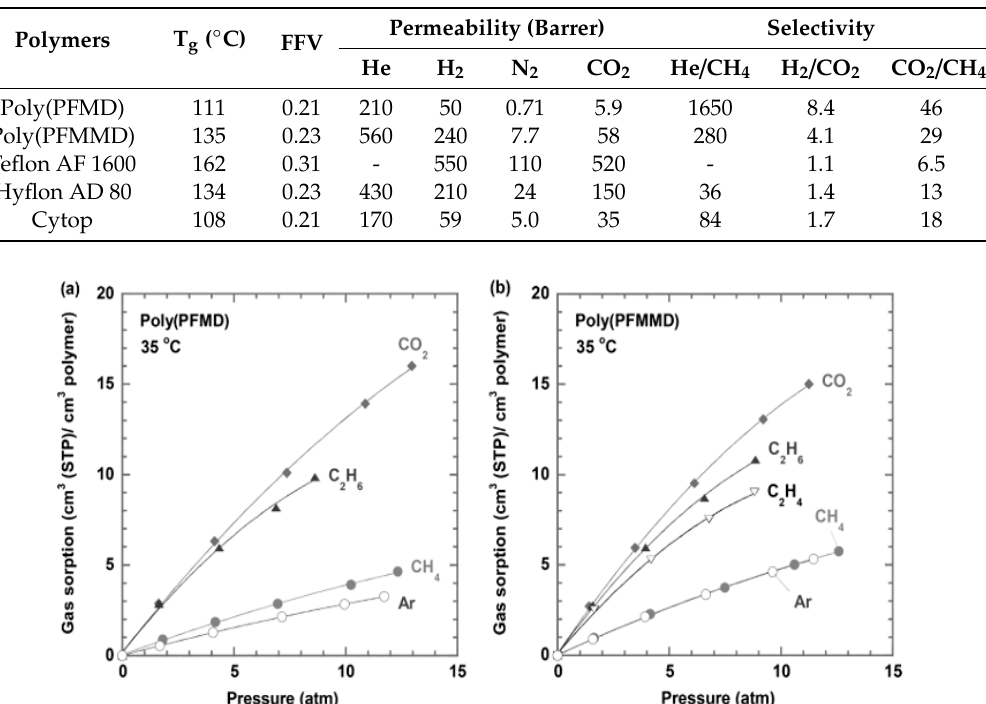
Figure 8. Effect of feed pressure on the pure-gas permeability of the freestanding films at 35 °C for ( a ) Poly(PFMD) and ( b ) Poly(PFMMD). Table 3. Comparison of Physical Properties and Gas Separation Properties (35 °C) of Poly(PFMD),